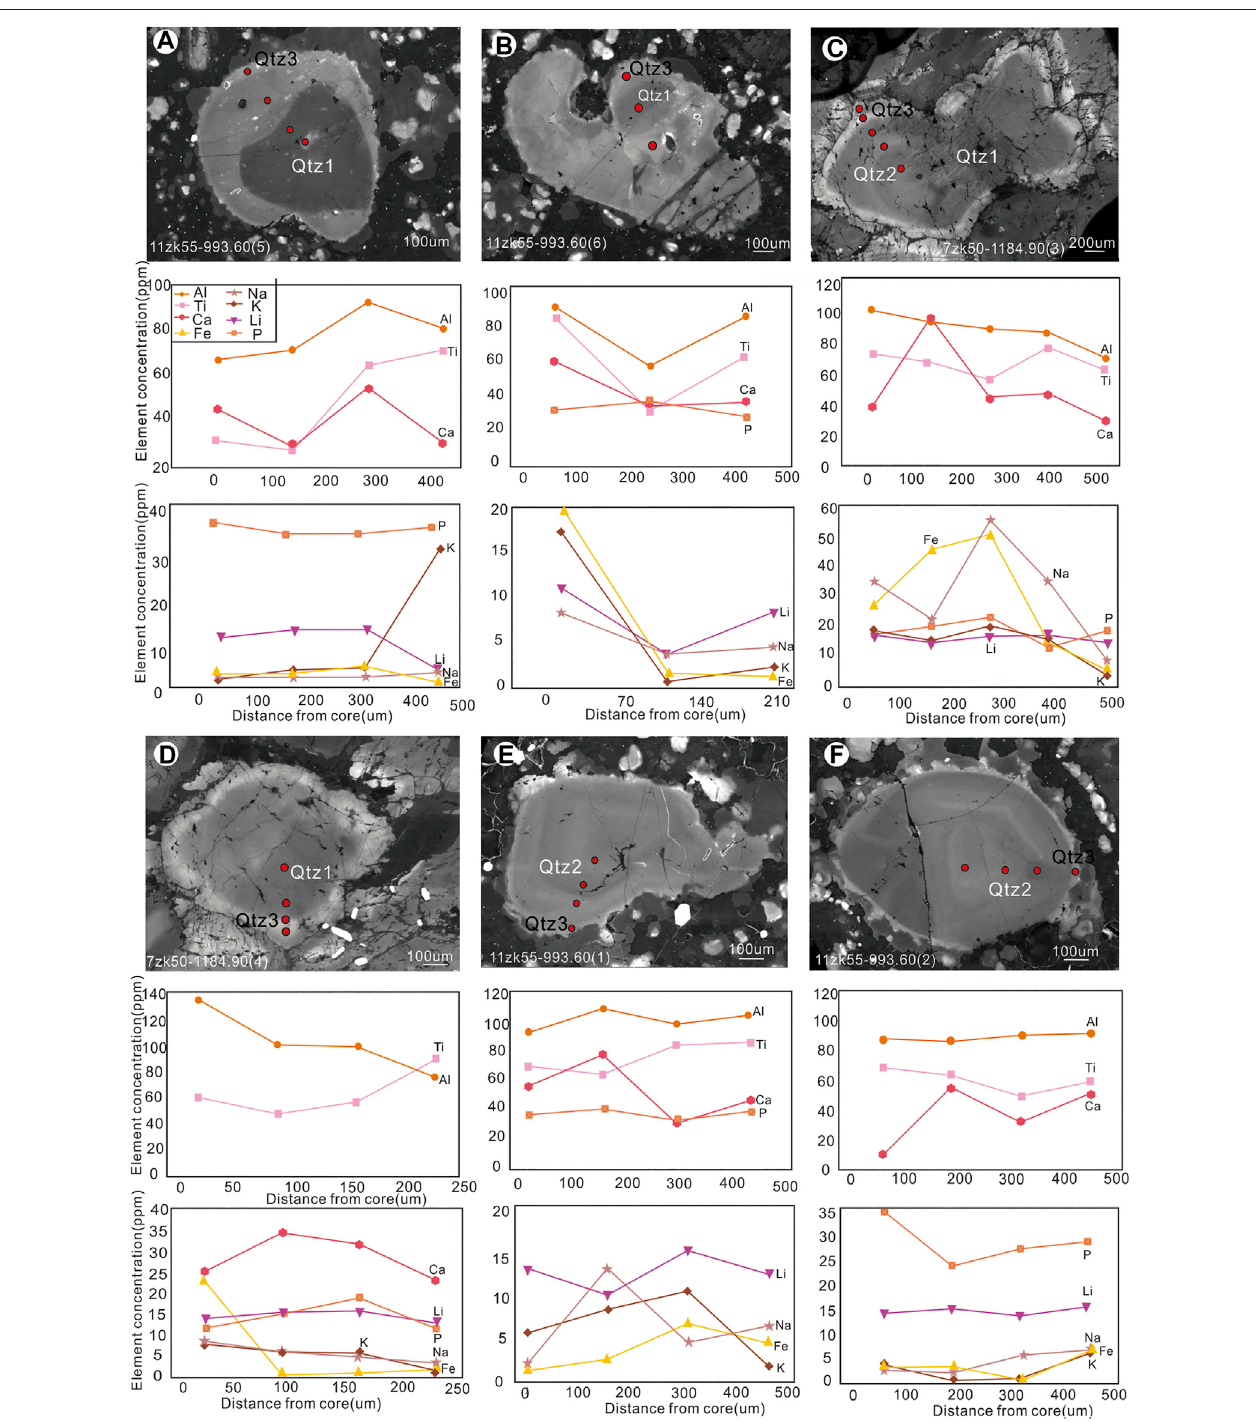
FIGURE 5 | Concentrations of trace elements in single quartz phenocrysts from their core to rim determined using LA-ICP-MS.